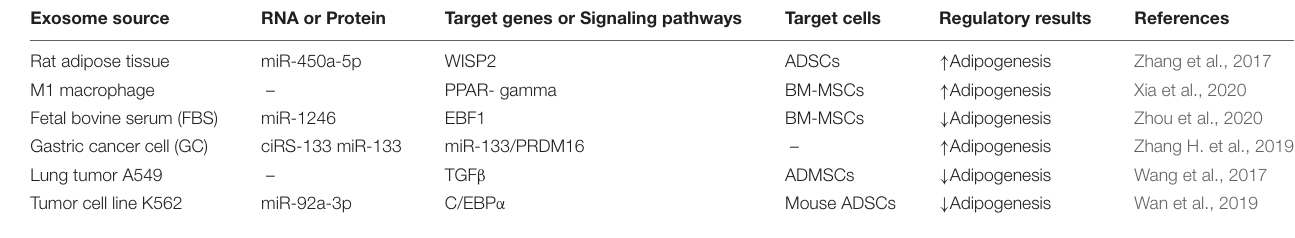
TABLE 4 | Exosomes regulate adipogenic differentiation. Exosome